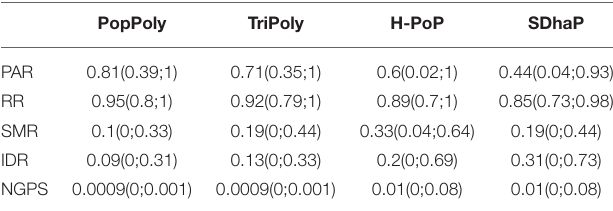
TABLE 2 | Average values and 95% confidence intervals for the quality measures of each haplotyping method, obtained by simulation at the sequencing depth of 5-5-2 × (mother-father-offspring) per